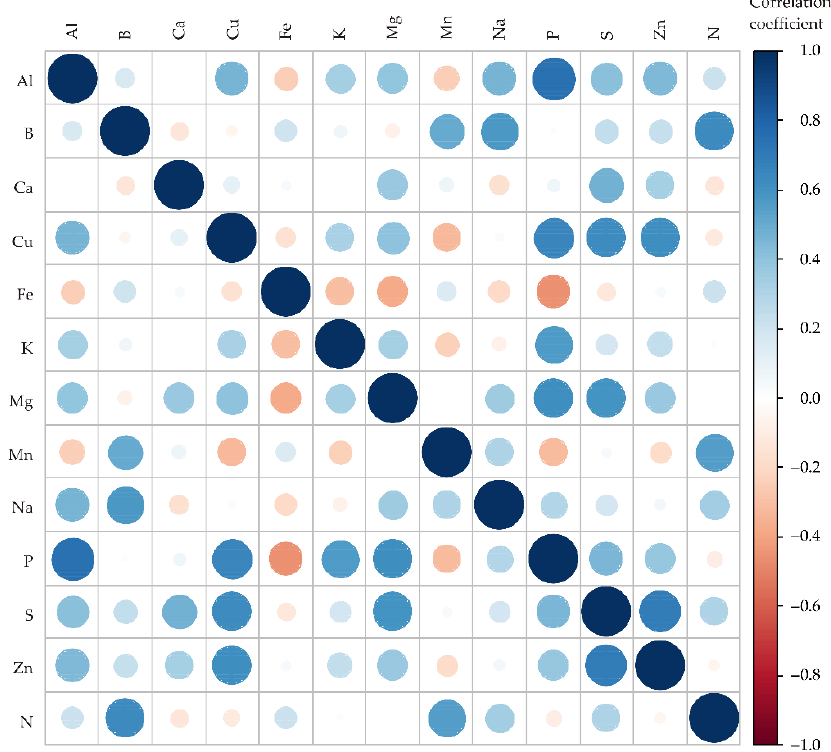
Figure A1. The averages of the values of TPC and RSA obtained for 18 raspberry varieties during the two-year collection.